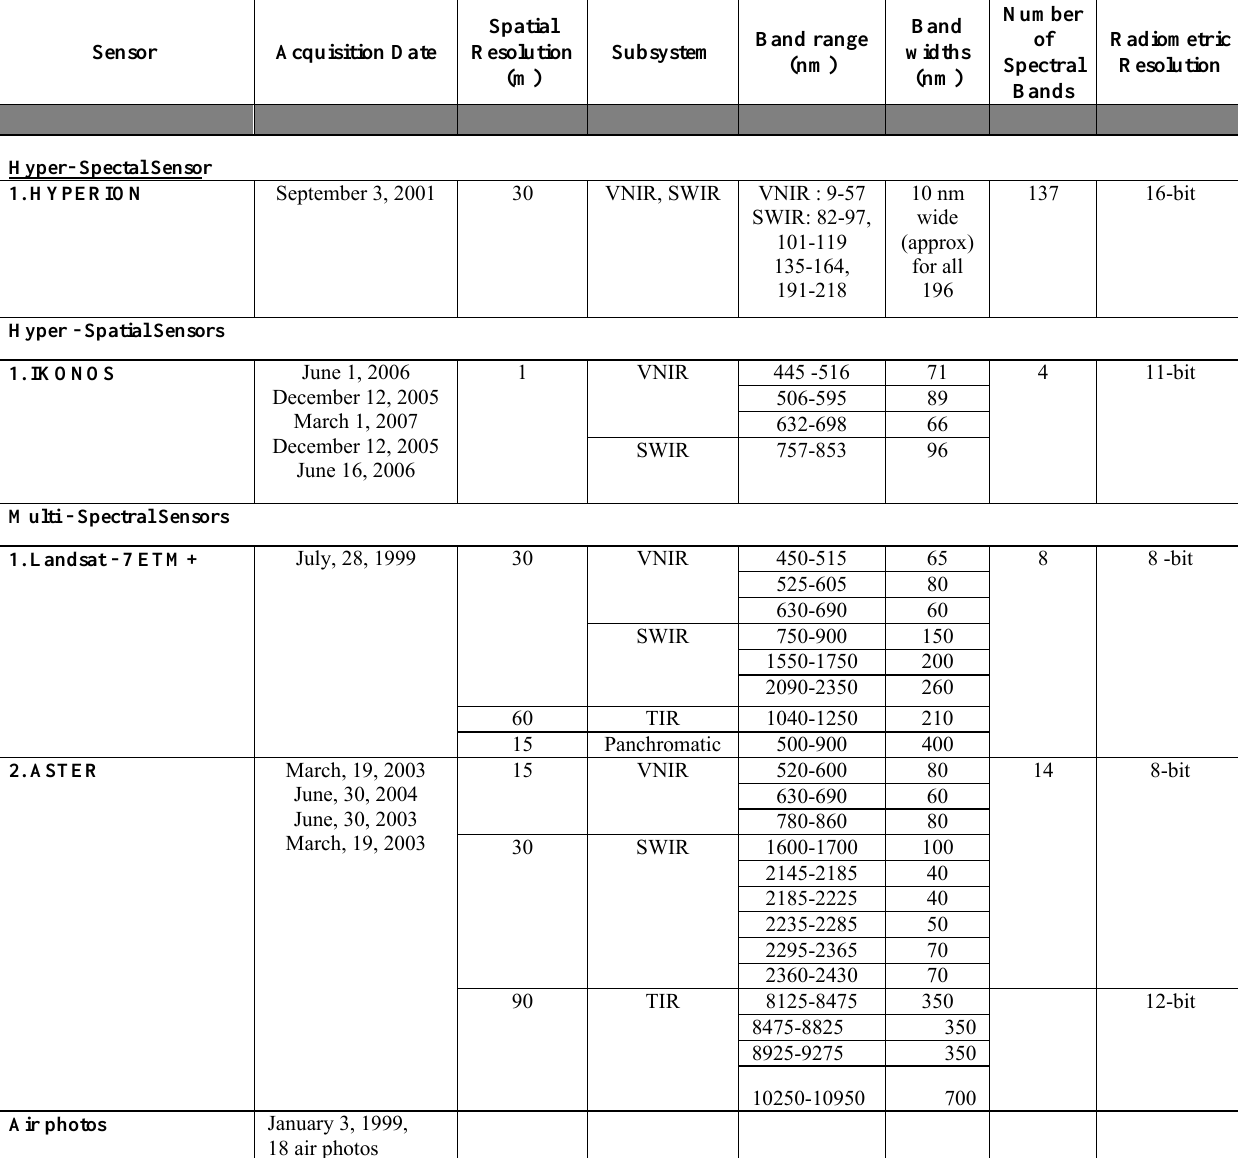
Table 1. Spectral, spatial and temporal attributes of the satellite sensors and air photos that were used for the